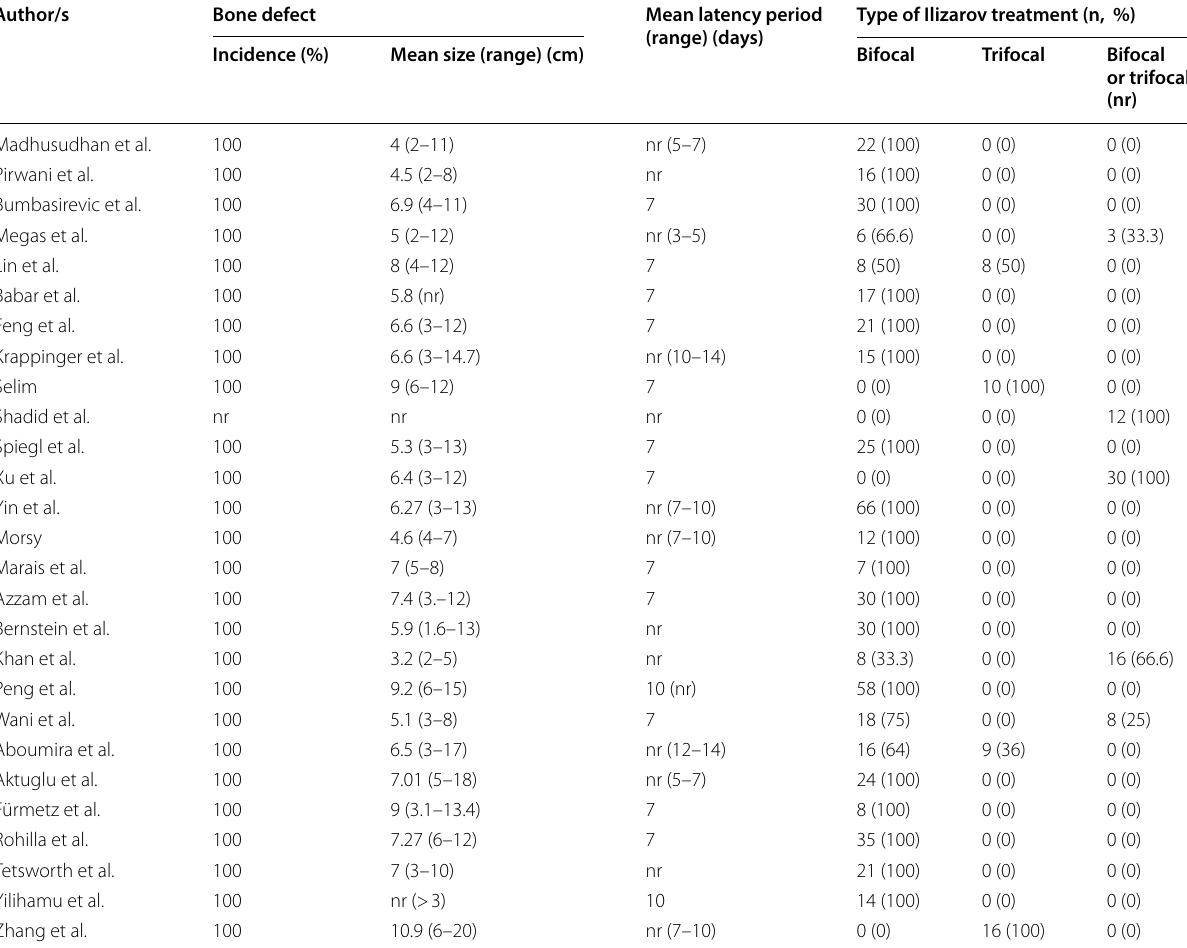
Table 4 Further details of applied